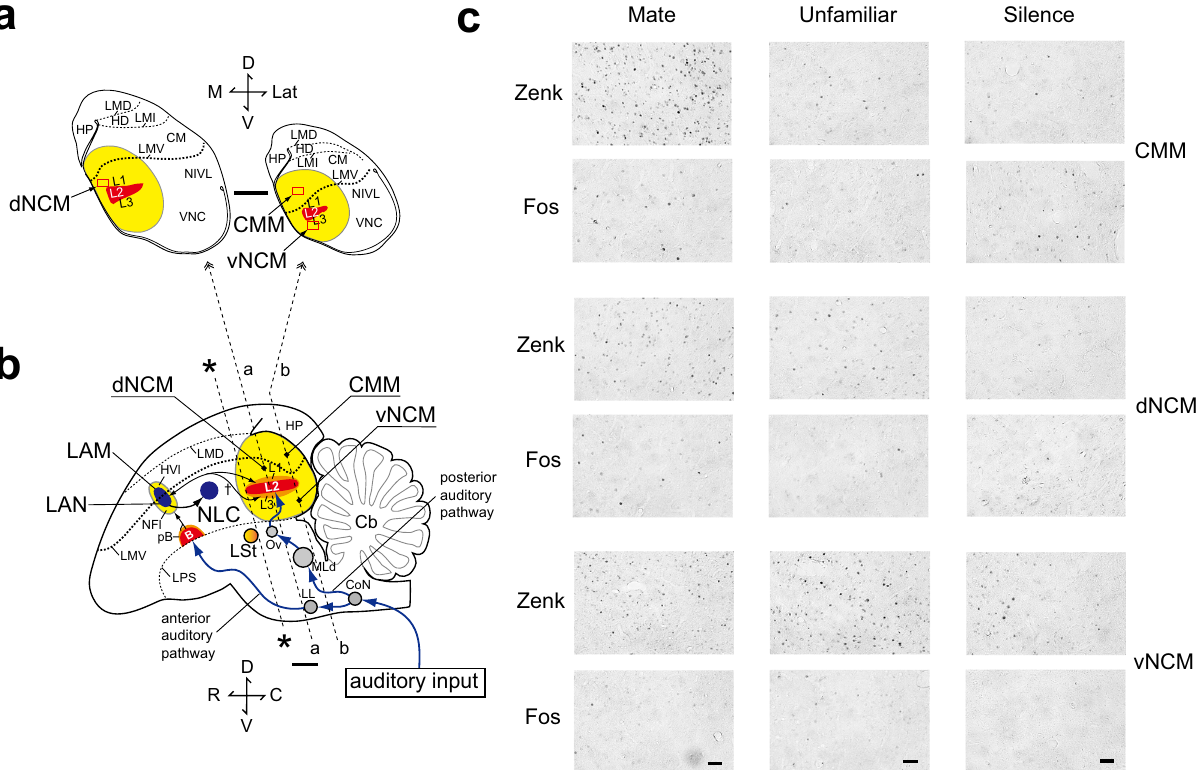
Figure 2. Zenk and Fos expressions in response to CCs in the budgerigar brain. ( a ) Coronal sections cut at level ’a’ and ’b’ in ( b ). Rectangles in the sections represent the counting frames. ( b ) A schematic drawing of a parasagittal plane in the auditory system. The caudal-most part of the LSt was defined as coordinates zero (*). Yellow regions indicate the caudomedial pallium ( a , b ) and a projection field (HVl/NFl) of the auditory B surrounding the LAM/LAN ( b ). Caudal and rostral lines shown in blue arrows in ( b ) indicate anterior and posterior auditory pathways, respectively. †; Reciprocal structural connections from the results of Farabaugh and Wild 64 . Lat, Lateral; Ros, Rostral; D, Dorsal; V, Ventral; C, Caudal; M, Medial. ( c ) Photomicrographs of coronal sections of the budgerigar brain showing Zenk- and Fos-immunoreactivity. See text for details. Scale bar represents 1 mm in ( a , b ) and 50 μm in ( c ). Anatomical Abbreviations: B, Basorostralis; Cb, Cerebellum; CM, Caudal mesopallium; CMM, Caudomedial mesopallium; CoN, Cochlear nucleus; HD, Densocellular part of the hyperpallium; HP, Hippocampus; HVC, A letter-based name, a vocal nucleus in songbirds (no abbreviation); HVl, Lateral ventral hyperstriatum (former name); L1, L2, L3, Subdivisions of Field L complex; LAM, Lateral nucleus of the anterior mesopallium; LAN, Lateral nucleus of the anterior nidopallium;